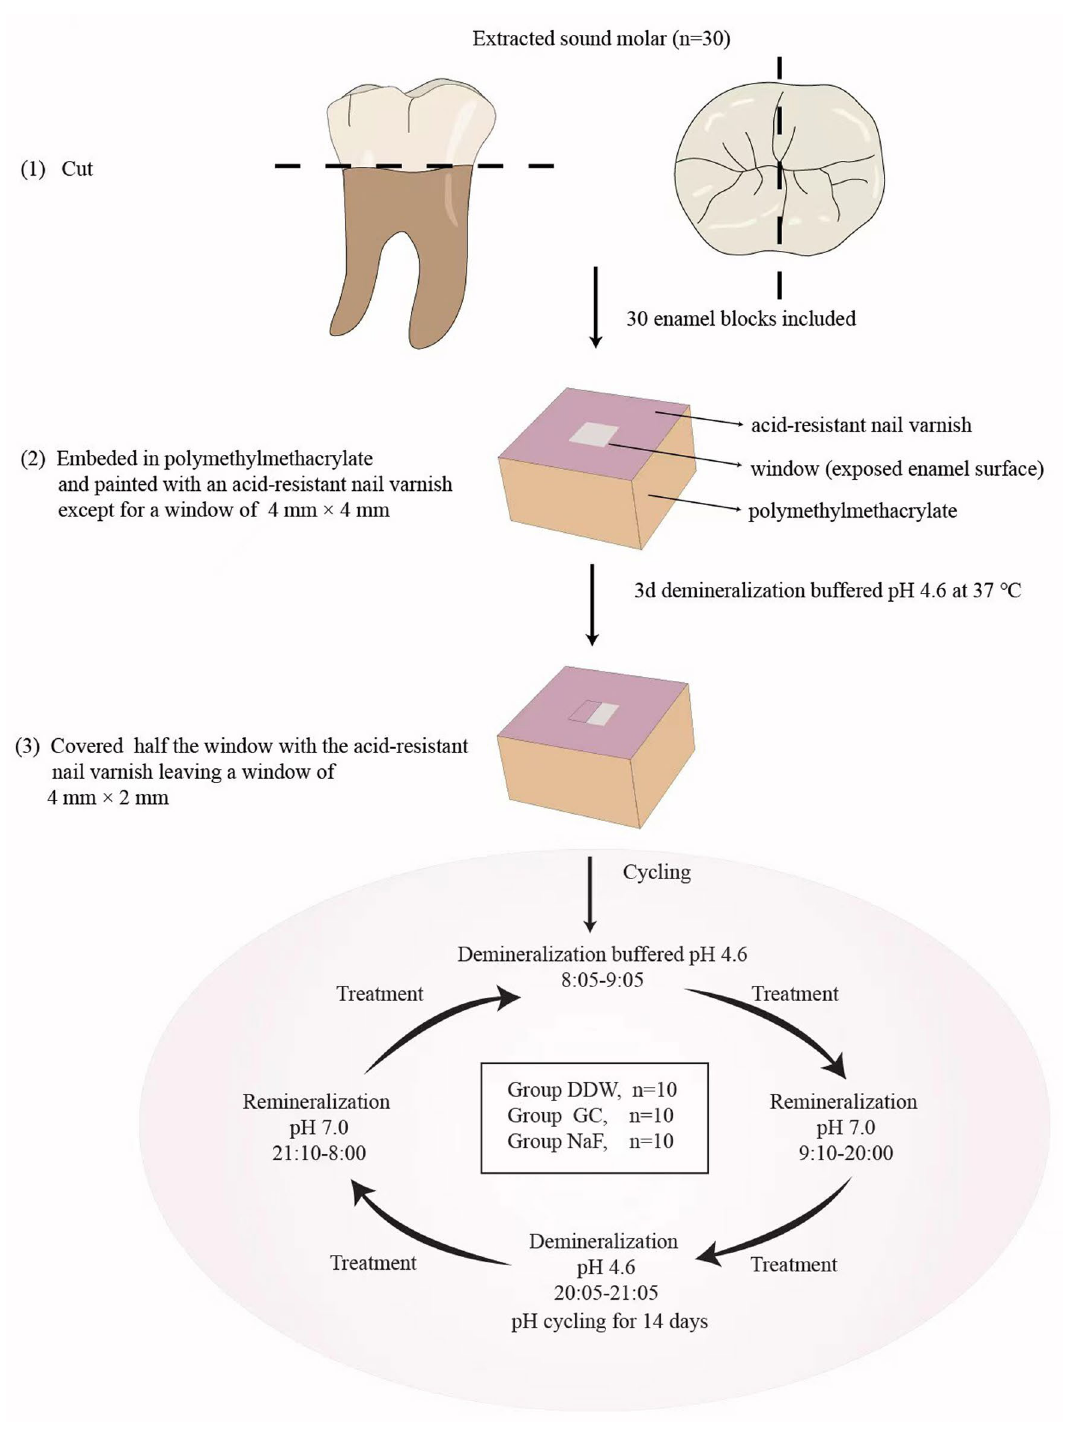
Figure 1. The flowchart of the experimental selected, and the surface roughness (Ra) of each field was analyzed by the Shimadzu SPM-9700 software (Shi- madzu, Kyoto, Japan). Then the average surface roughness of each sample and each group was calculated. Transverse microradiography (TMR) examination. The samples were cut into 150 μm-thick slices perpendicular to the exposed windows with a diamond-coated band saw (EXAKT300; EXAKT, Norderstedt, Germany), ground all the slices to a thickness of 100- to 120-μm via 2000 grit carbide-polishing papers (Yu Ying, Foshan, China), and verified using a digital micrometer (Mitutoyo, Tokyo, Japan). Each slice was fixed on Plexi- glass slides (Konica Minolta, Tokyo, Japan) in a TMR sample holder (Inspektor Research Systems, Amsterdam,